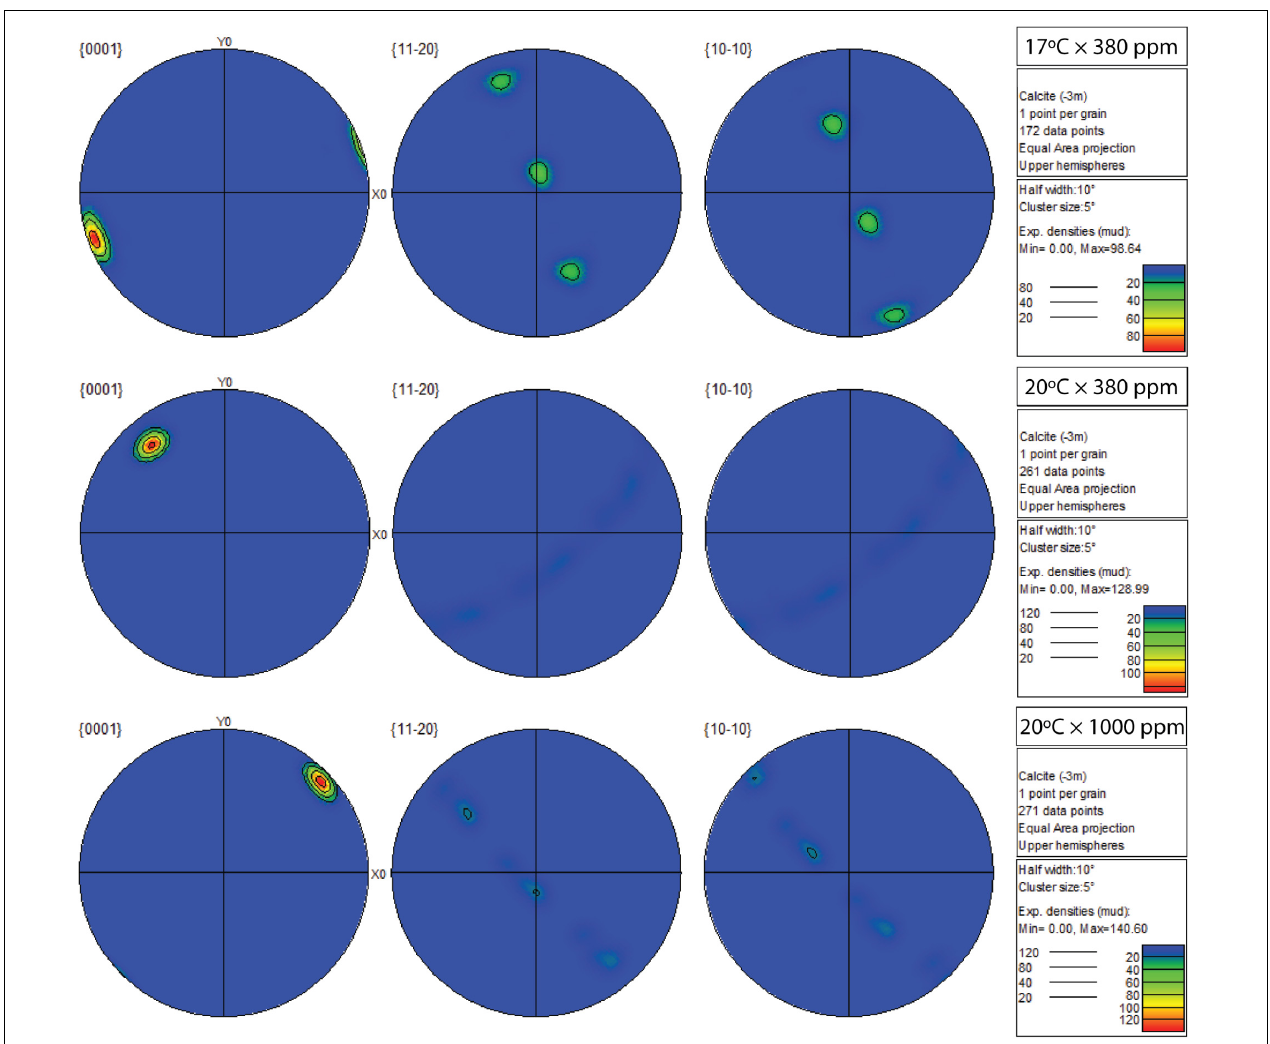
FIGURE 6 | Contoured pole figures (1 point per grain analysis) showing variation in crystallographic orientation along three crystal planes (0001; 11-20; 10-10) in Mytilus sp. grown for 8-week under three climate scenarios (top: 17 ◦ C × 380 ppm; middle: 20 ◦ C × 380 ppm; bottom: 20 ◦ C × 1000 ppm). The clear single-crystal fabric observed in the control data (top row) becomes more diffuse along both short axes ({11-20} and {10-10}) as temperature (20 ◦ C × 380 ppm), or temperature and CO 2 (20 ◦ C × 1000 ppm)